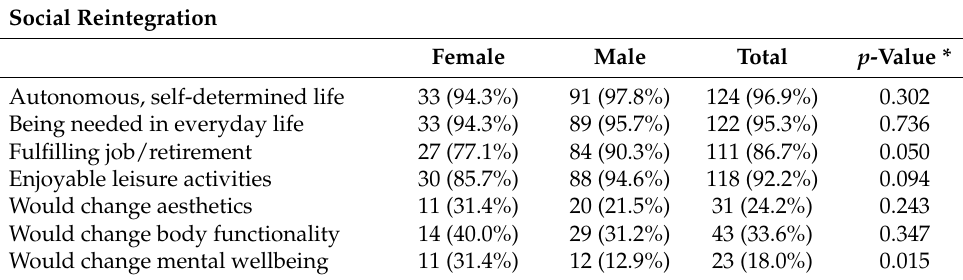
Table 6. Outcome of complementary questions considering life